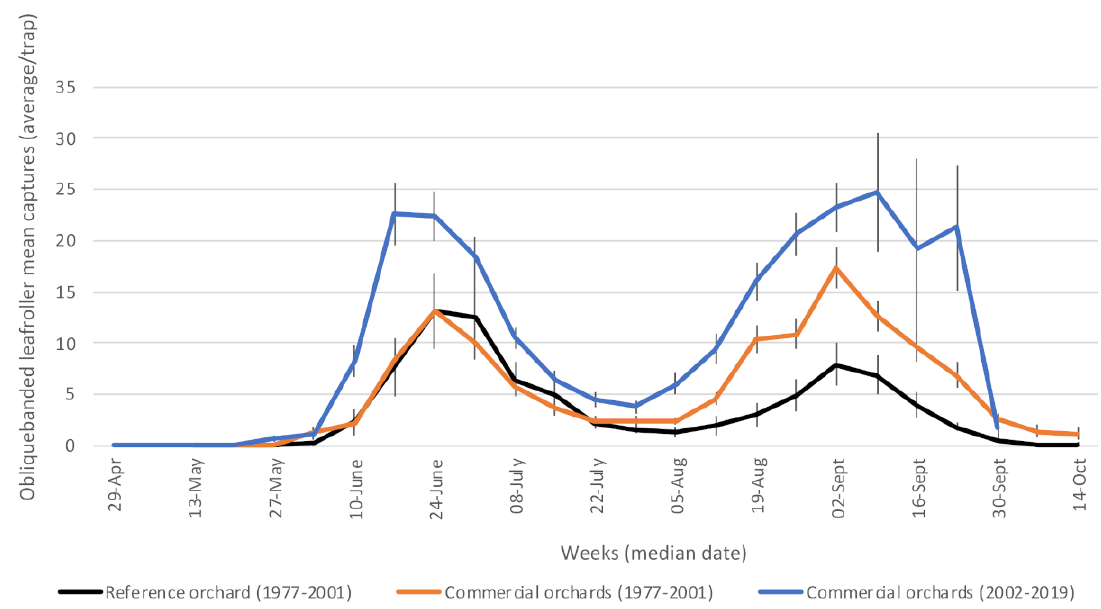
Figure 5. Average captures of adult oblique-banded leafroller in participating orchards. Reference (insecticide-free) orchard located at Frelighsburg, Qc (Agriculture and Agri-Food Canada, 1977–2001). Commercial orchards located at Franklin, Hemmingford, Oka, Rougemont and Saint-Paul-d’Abbotsford. Vertical bars represent standard